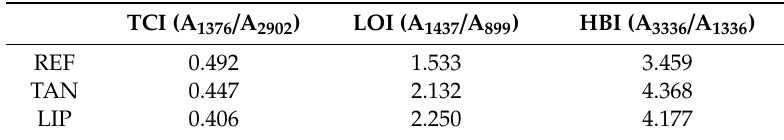
Table 1. Infrared total crystallinity (TCI), hydrogen bond intensity (HBI) and lateral order index (LOI) for the obtained